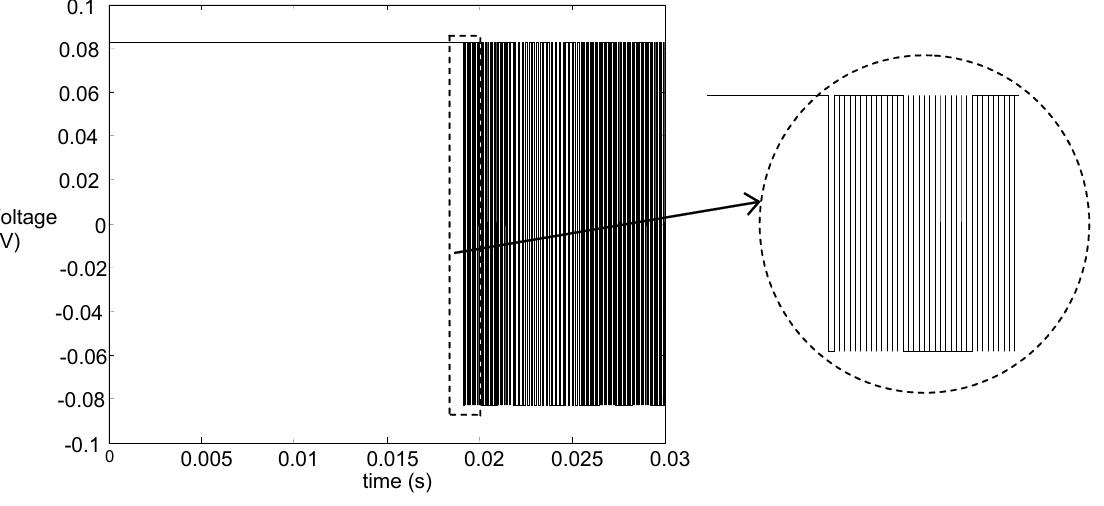
Figure 7 . Sequence of impulses at the input of the integrator.